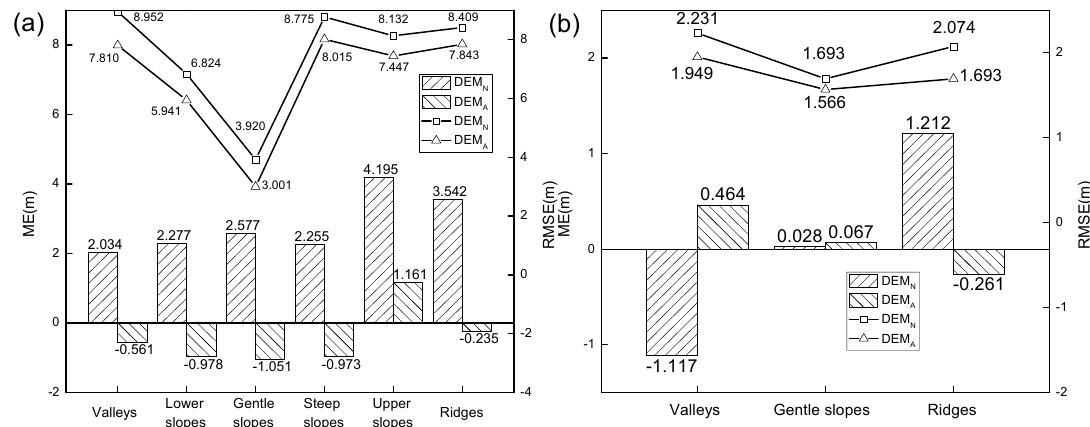
Figure 13. The ME and RMSE of the DEM N and DEM A in different slope position classes in ( a ) site A and ( b ) site B. Table 5. Performance of the adjusted DEM in comparison with the DEM N at study sites A and B.